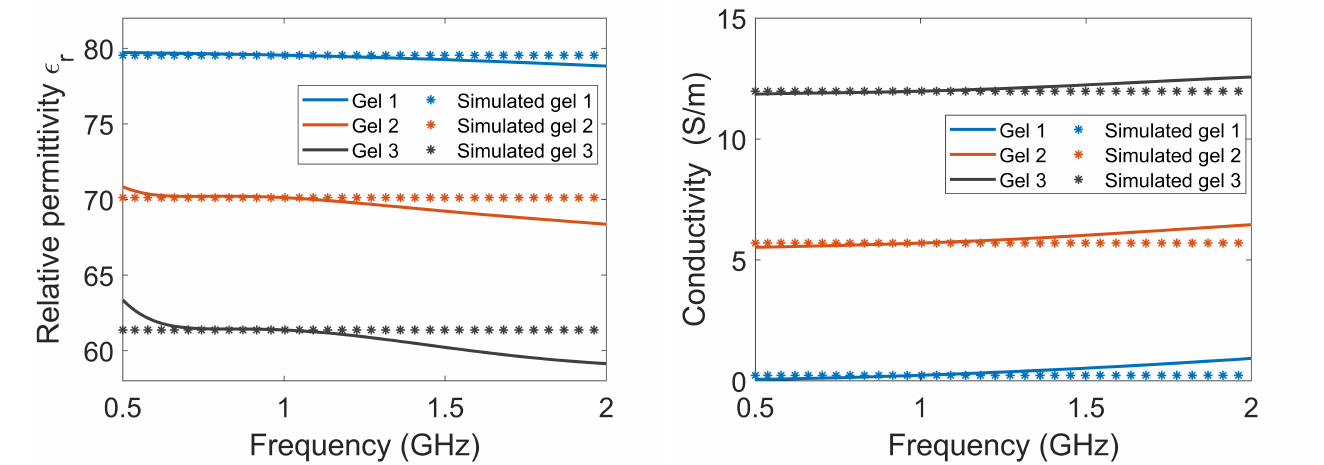
Figure 2. The relative permittivity and conductivity of the three lossy gels. The measured data of the gels, as well as the corresponding properties that were used in the simulations, are